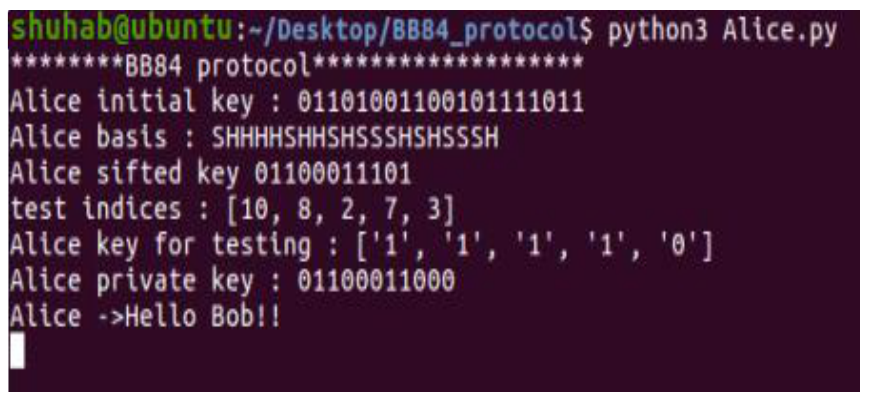
Figure 7. OTP sender (Alice).